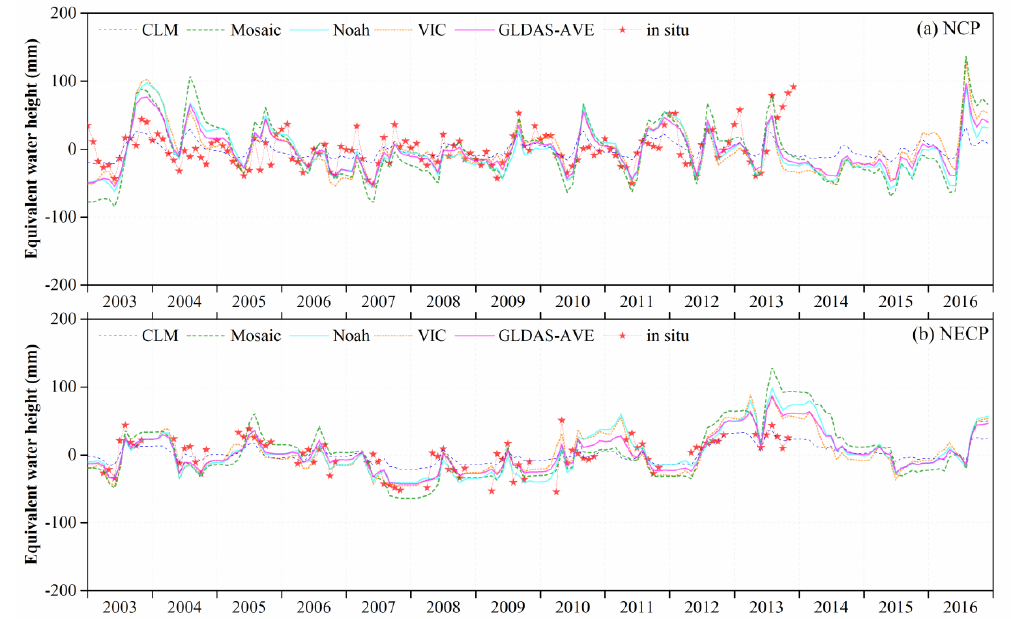
Figure 3. Monthly time series of soil moisture storage anomalies (SMSA) from four Global Land Data Assimilation System (GLDAS) models (CLM, Mosaic, Noah, VIC) and their average (GLDAS-AVE) compared with in situ data in the NCP ( a ) and NECP ( b ).